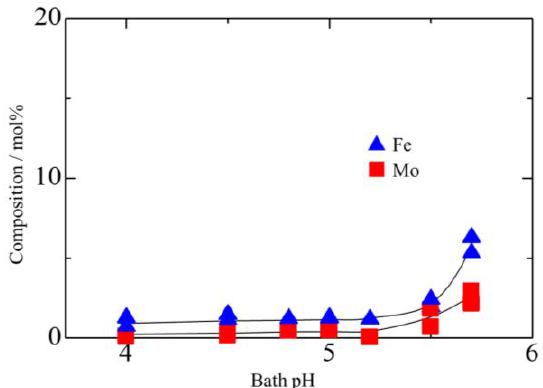
Figure 2. The content of Fe and Mo in Zn–Fe–Mo plating deposited at various pH values.